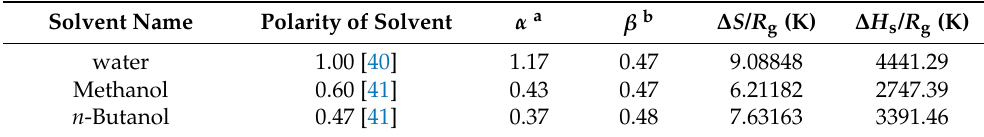
Table 2. Solvent polarity, hydrogen bond donor ability, hydrogen bond acceptor ability and dissolu- tion enthalpy values.